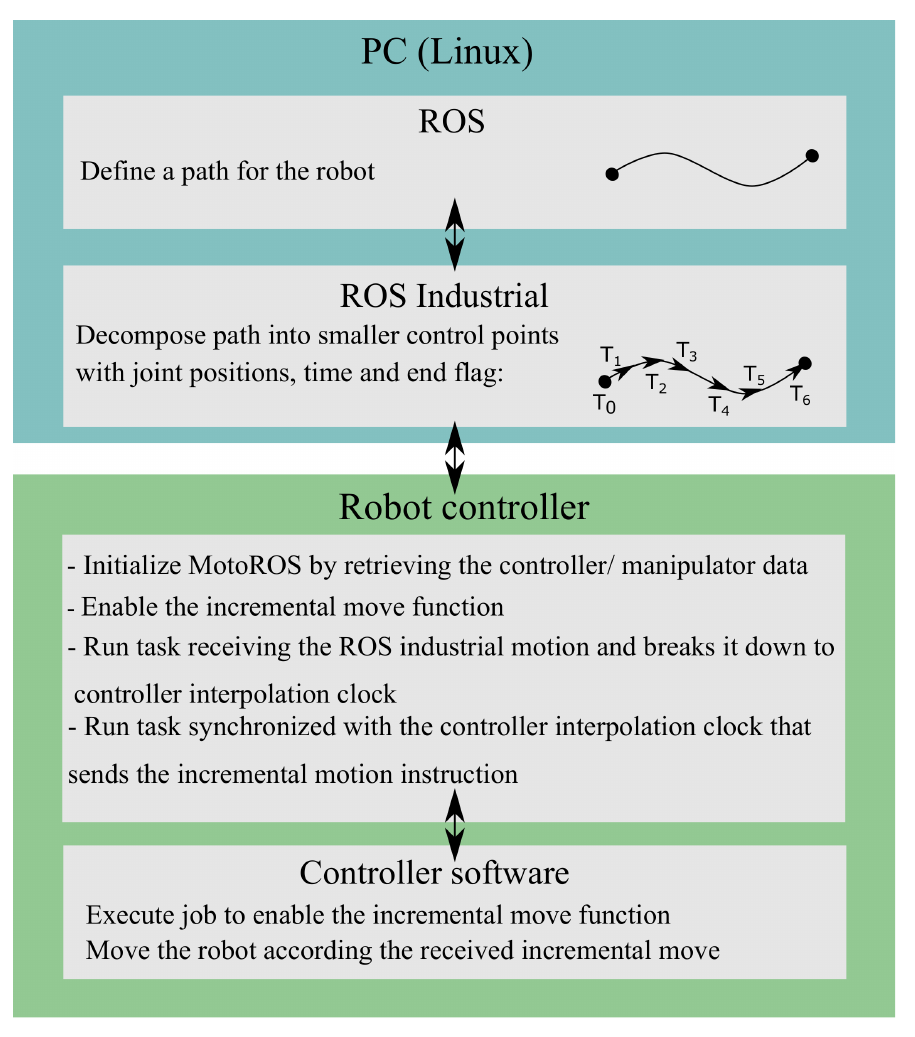
Figure 3. System architecture